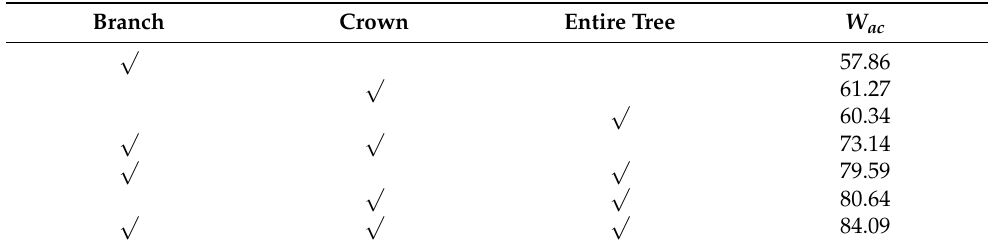
Table 4. Overall weighted accuracy of four species achieved using all structural parameters in each group, each two groups and all three groups,